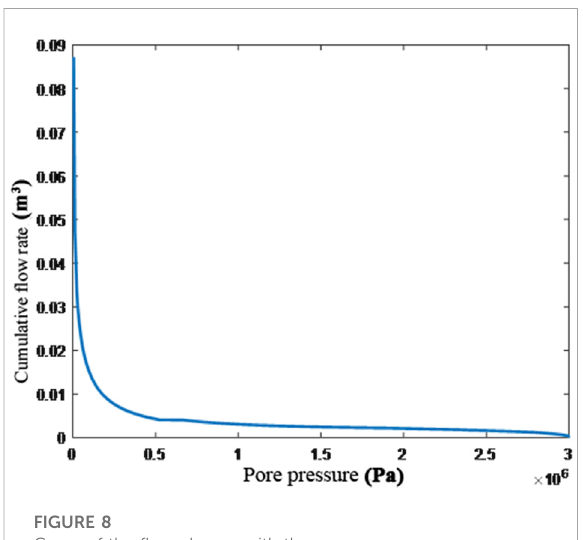
FIGURE 8 Curve of the fl ow change with the pore